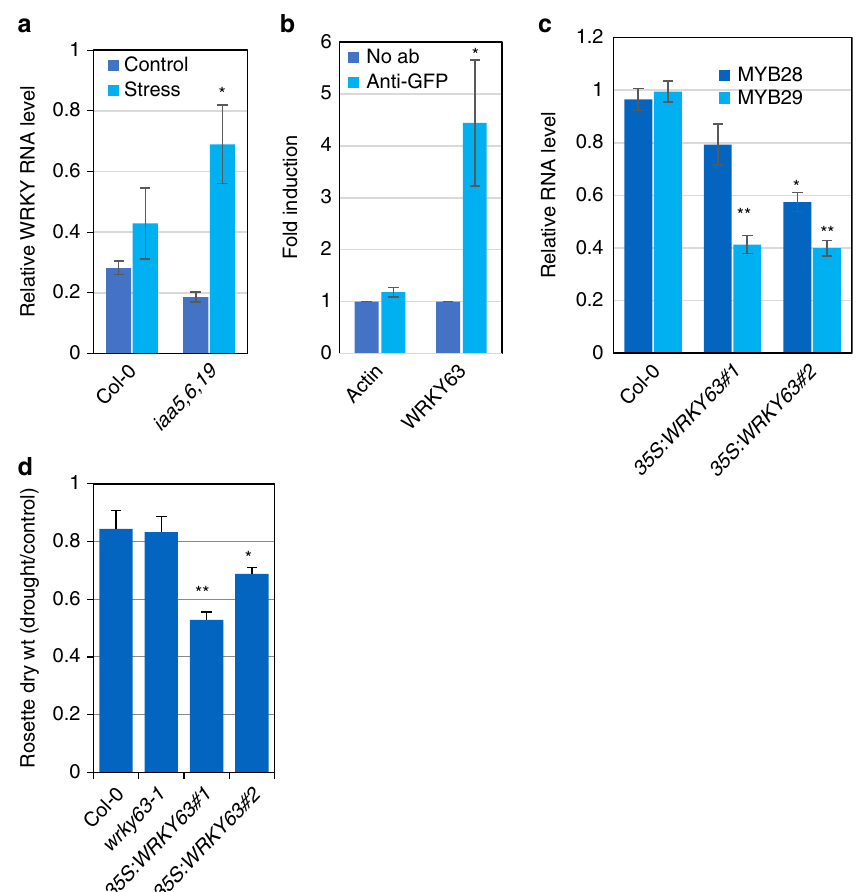
Fig. 3 Drought activates a transcriptional cascade to regulate GLS biosynthetic genes. a Relative WRKY63 RNA level in the iaa5,6,19 mutants compared to wild-type seedlings before and after desiccation for one hour. b IAA19 binds to a tandem repeat of AuxRE elements in the promoter of WRKY63 ( − 350 to − 361). ChIP was from the rAA19-YPet-His-FLAG line. Results are presented as the means ± SE of 3 independent biological experiments with 3 technical replicates in each. Statistical signi fi cance was determined by two-tailed Student ’ s t test. ** P < 0.05. c Relative MYB28 and MYB29 RNA level in the seedlings of 35 S:WRKY63 lines. d 35 S:WRKY63 lines are less tolerant to drought than wild-type plants after water withholding in pots. Results are presented as the means ± SE of one independent experiments with n = 10 independent pots/plants. Differences are signi fi cant at p < 0.05 ( ∗ ) and p < 0.01 ( ∗∗ ) by two-tailed Student ’ s t test. Source data are provided as a Source Data fi